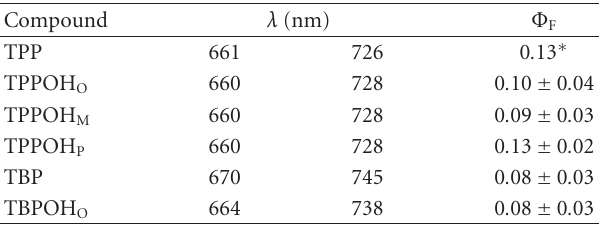
Table 1: Wavelength maximum of the fluorescent emission bands, λ , and fluorescence quantum yield, Φ F , for the series of unsymmet- rically substituted mesoporphyrins in benzene for air equilibrated samples.